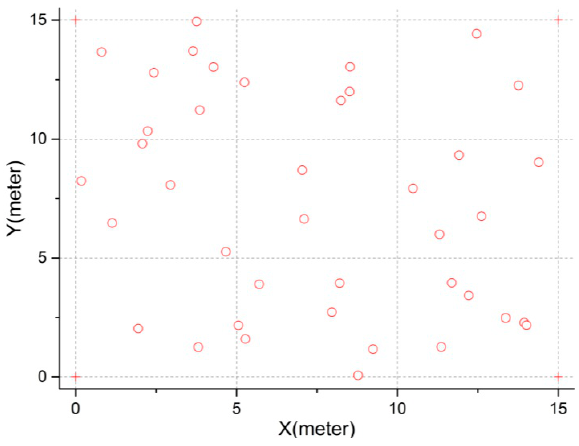
Figure 8. Deployment diagram of 44 sensor nodes with 4 anchor nodes ( + ) and 40 unknown nodes ( ◦ ) in 15 × 15 m 2 sensor field.